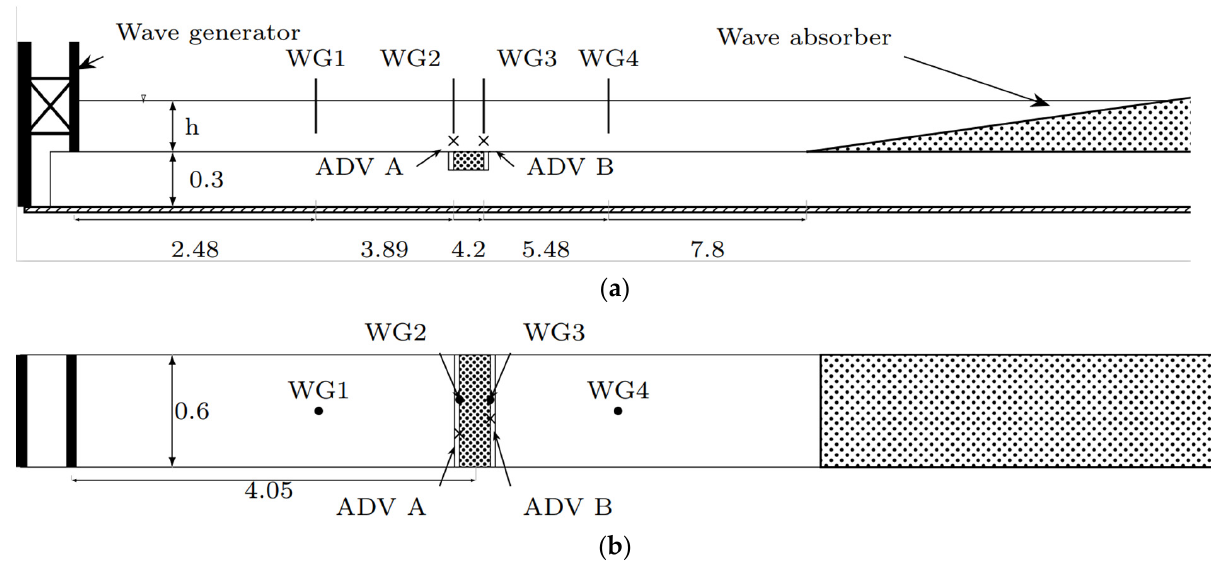
Figure 3. Experimental setup in a wave flume for measurements of wave-induced sediment transport: ( a ) side view of the wave flume with the sand box implemented; ( b ) side view of the wave flume.